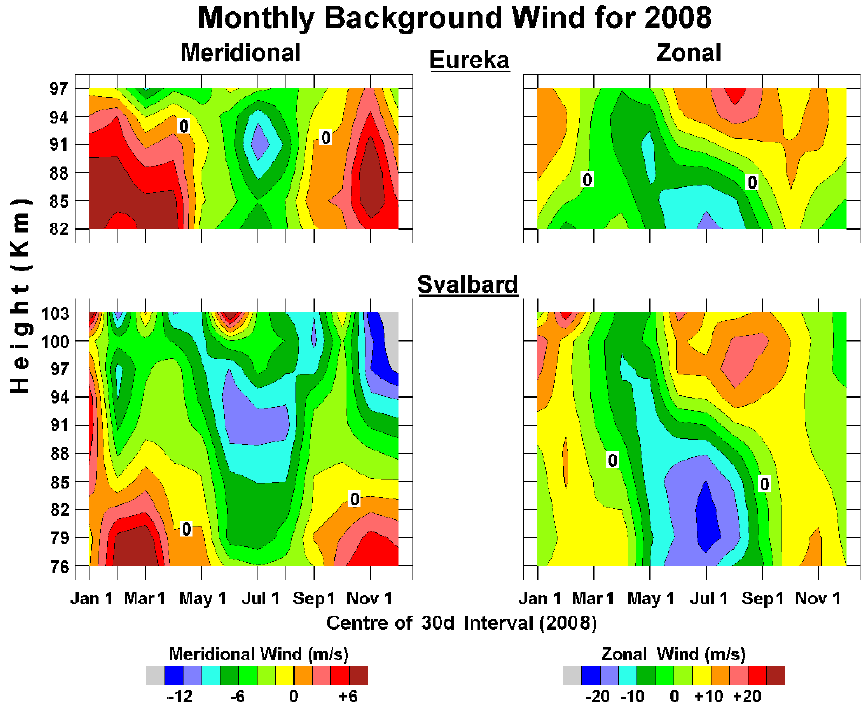
Fig. 4. Background winds for 2008 from the Eureka and Svalbard MWR: these are from thirty-day fits for the mean winds and 12- and 24-h tidal oscillations. The fits have the first day of each month as their